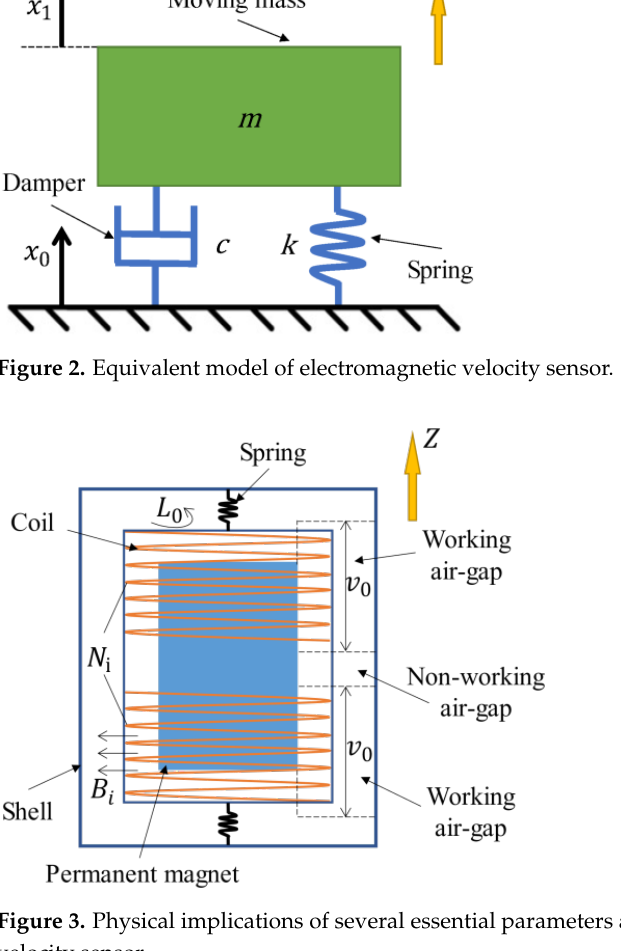
Figure 3. Physical implications of several essential parameters and structures in an electromagnetic velocity sensor.